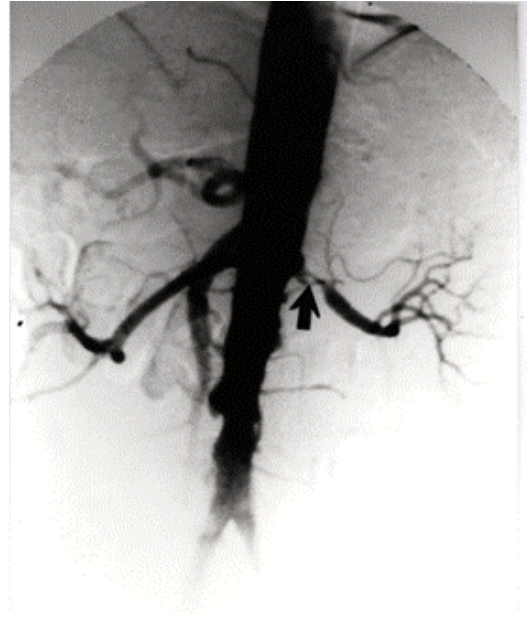
FIGURE 2 . Postoperative angiogram showing widely patent end to end splenic artery to left renal artery